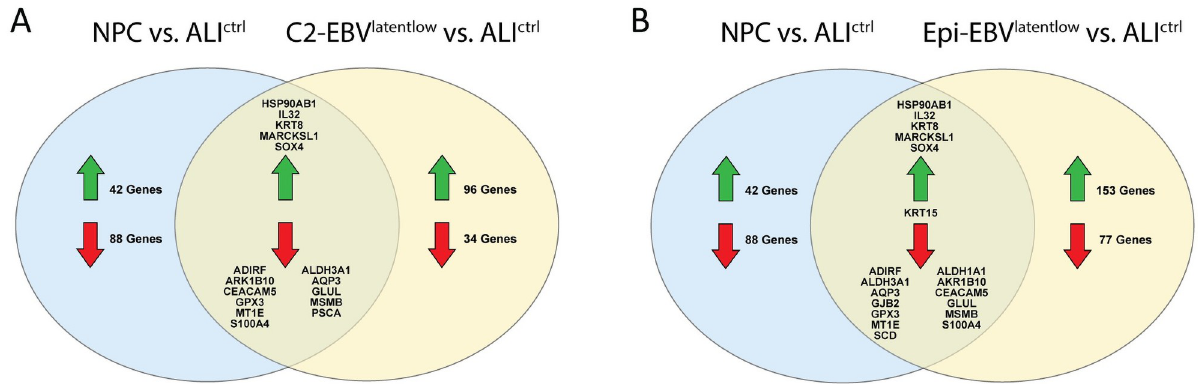
Fig 10. Venn diagram of differentially expressed genes. (A, B) NPC tumors (NPC36, NPC46 and NPC50, [39]), (A) EBV latentlow cells from cluster 2 (C2-EBV latentlow ), and (B) EBV latentlow cells from all epithelial clusters (Epi-EBV latentlow ) in the EBV-infected pseudo-ALI culture from donor no. 4 were compared against an uninfected pseudo-ALI culture from [41] as reference control (ALI ctrl ).